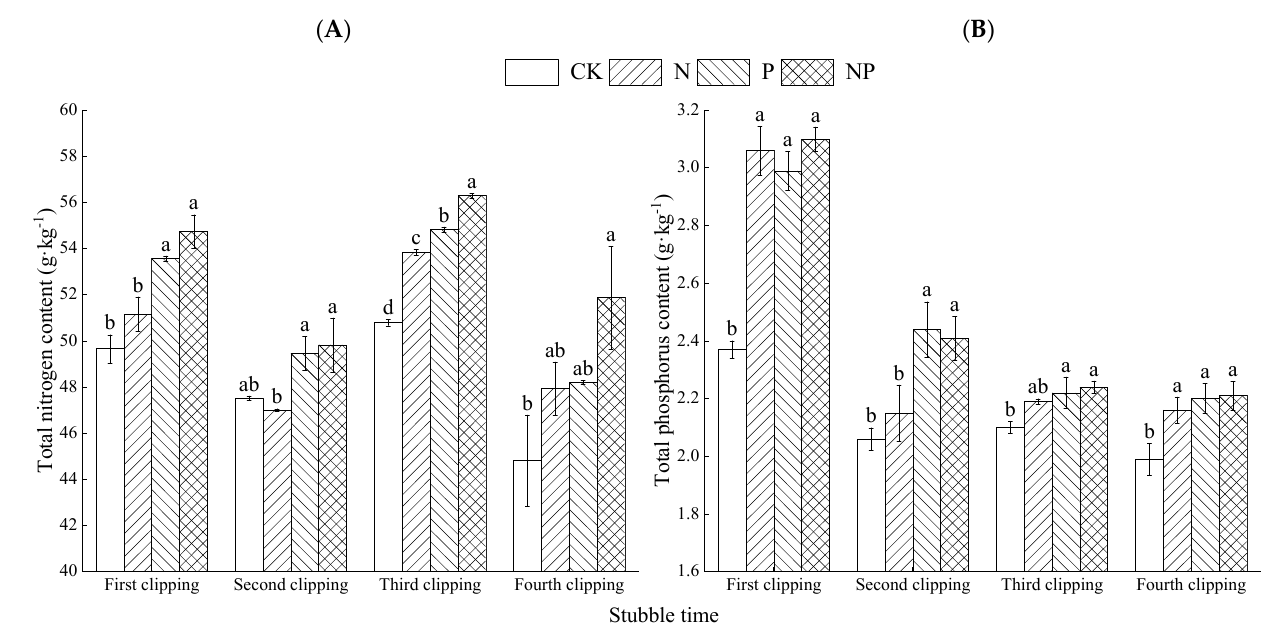
Figure 2. Effect of nitrogen and phosphorus on total nitrogen and total phosphorus content of ( A ) total nitrogen content and ( B ) total phosphorus content of alfalfa leaves. Different letters above col-umn indicate significant difference among treatments with different ( p < 0.05).